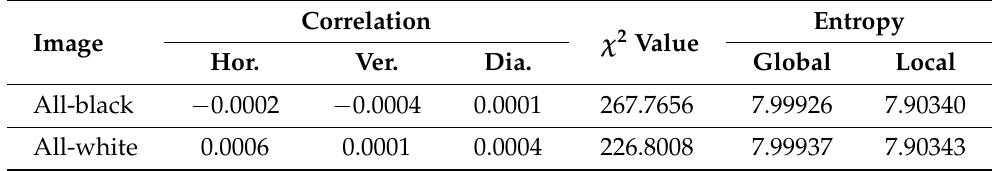
Table 7. Statistical analyses of the cipher all-black and all-white images.